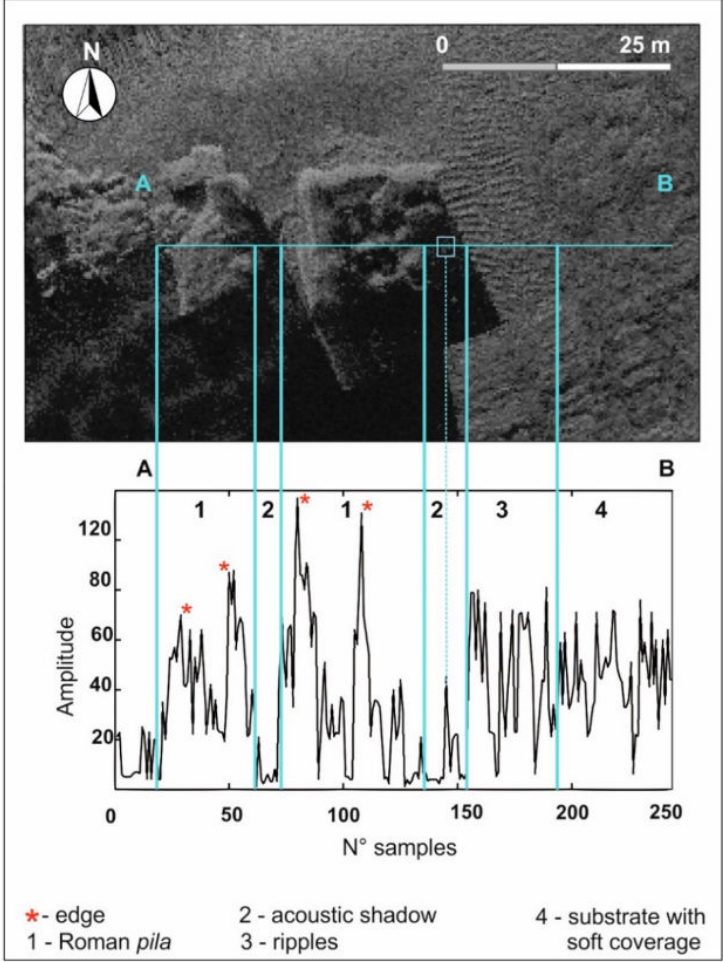
Figure 13. Backscattering signal chart of a sweep passing through the archaeological structures with the amplitude of the acoustic signal expressed in grey